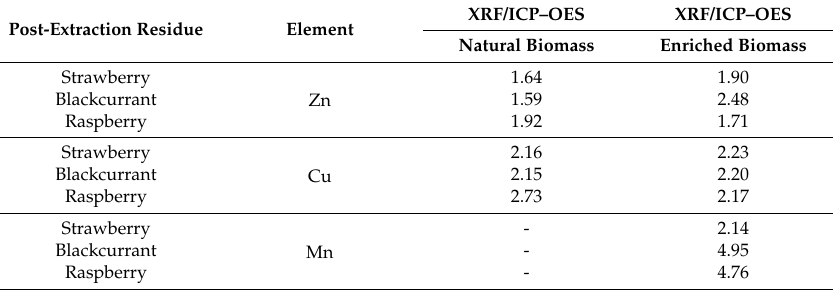
Table 4. Comparison of the coefficient (XRF/ICP-OES) of the microelement content in the biomass. Post-Extraction Residue Element